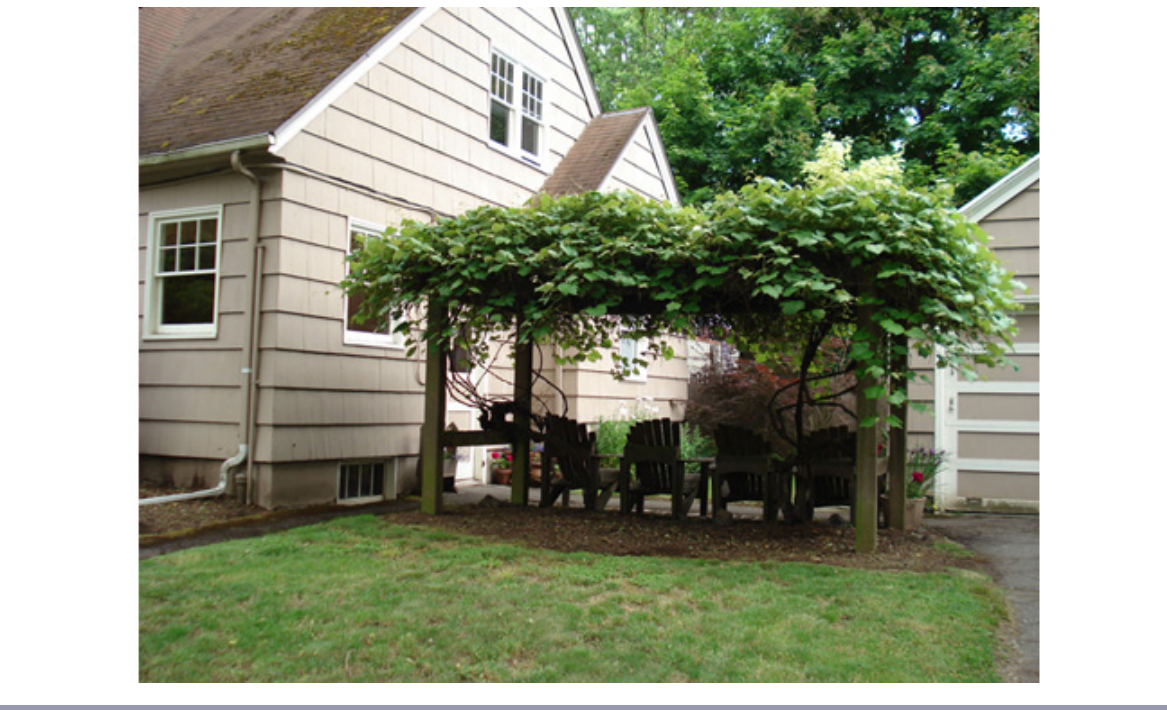
Figure 4. A grapevine arbor in a residential yard provides shade as well as an edible product for the